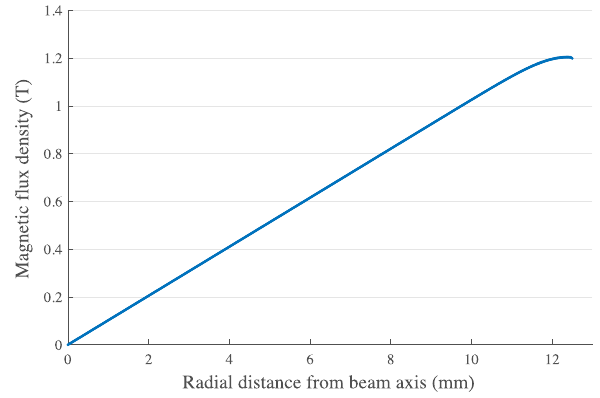
FIG. 16. Field strength along the transverse axis of the magnet, with concentric rings aligned for maximum field gradient.